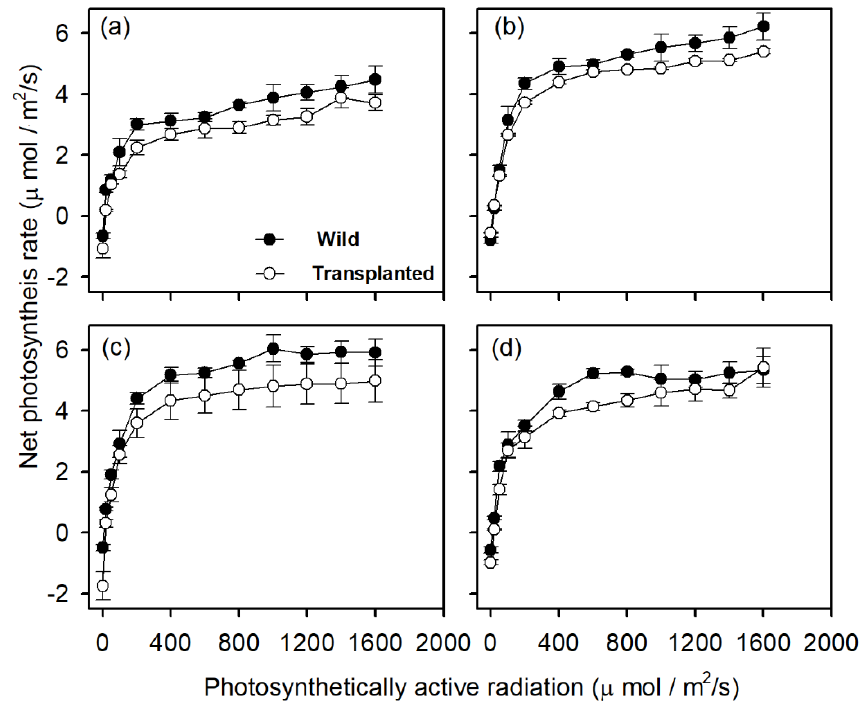
Figure 5. Light response curves of measured photosynthesis rates of wild and transplanted Cypri- pedium calceolus ( a ), C. guttatum ( b ), C. macranthos ( c ) and C. × ventricosum ( d ), respectively. Table 5. Results of light response curve given by a modified model of the rectangular hyperbola of four Cypripedium species.